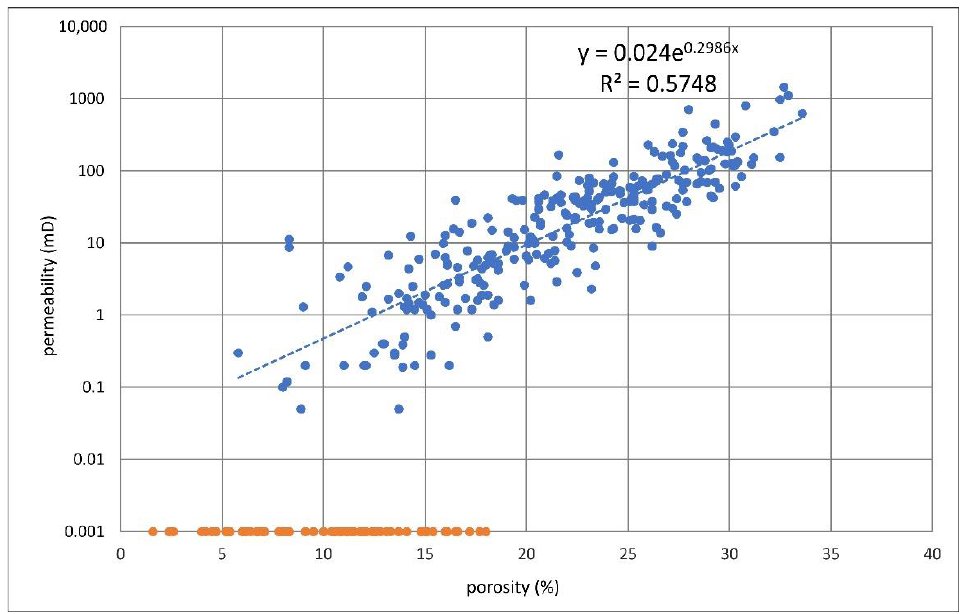
Figure 4. Relationship between porosity and permeability based on the results of laboratory measurements on core samples (blue dots represent porosity – permeability values showing correlation, and orange dots represent the group of porosity – permeability values of samples that were reported as impermeable).